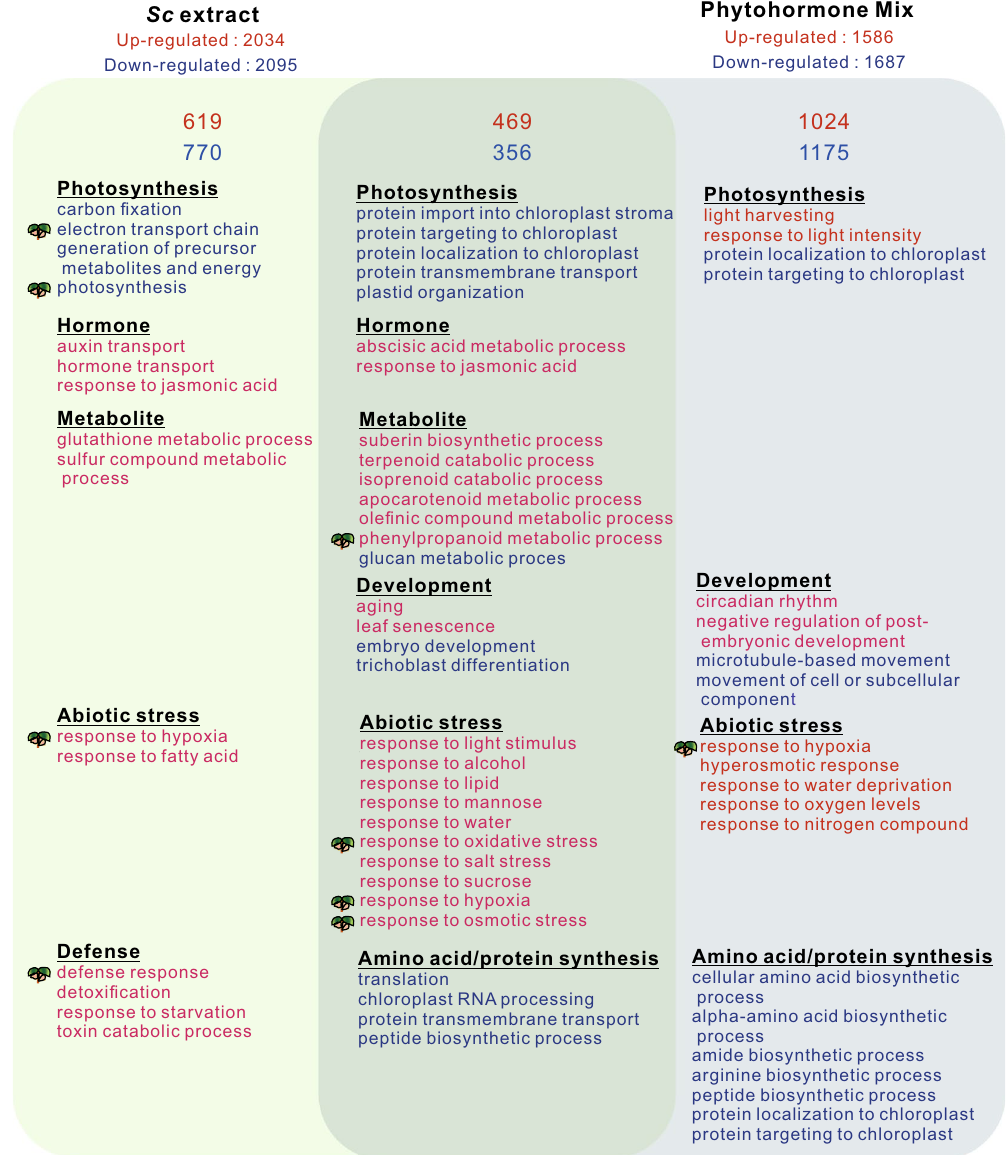
Figure 7. Venn diagram analysis of the number of increased differentially expressed genes (DEGs) in the Arabidopsis seedlings following Schlechtendalia chinensis extract treatment and phytohormone mixture treatment. The number in each circle represents the number of upregulated DEGs in each treatment. The number in the overlapping region indicates the shared DEGs between the two treatments. Descriptions in each region indicate the typically enriched gene ontology categories of the corresponding